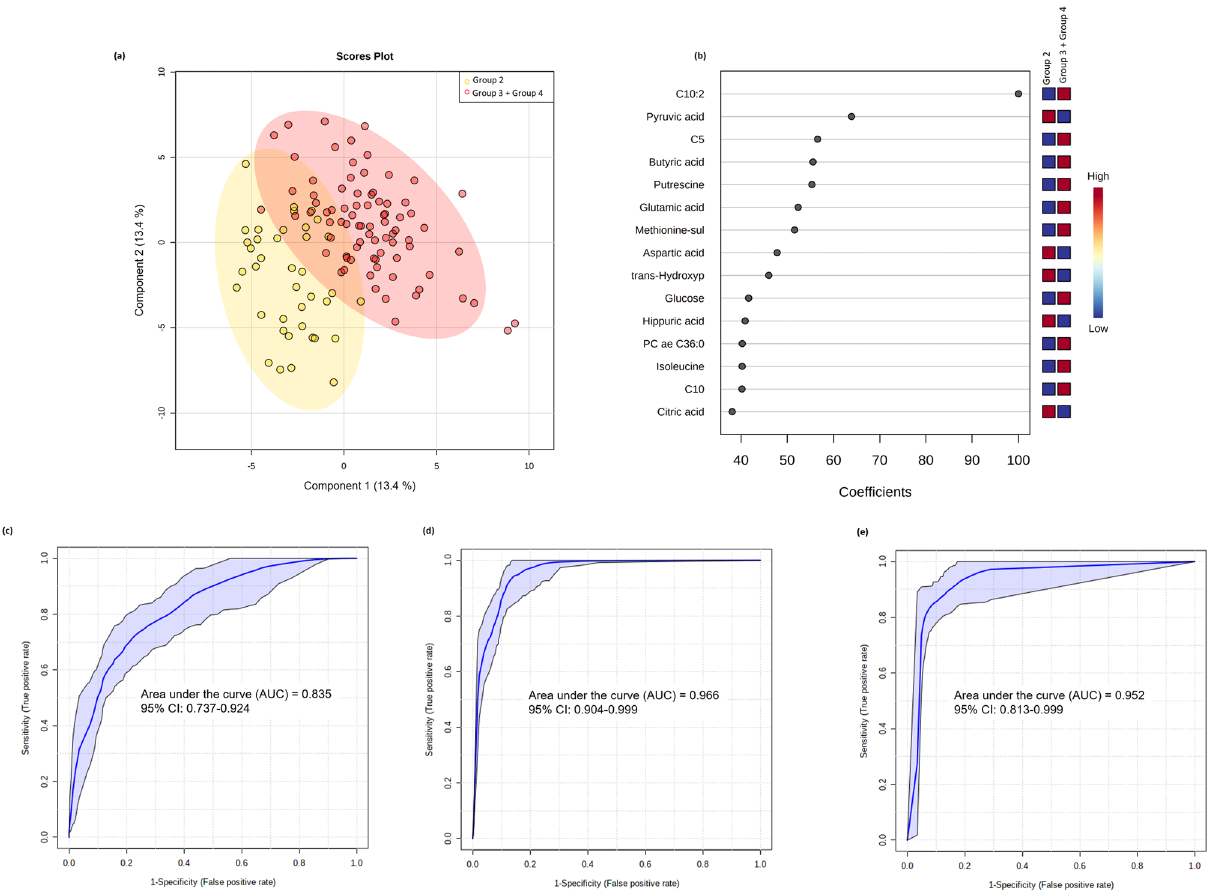
Figure 2. Multivariate analysis from plasma metabolome profile of G2 versus G3 and G4 patients. ( a ) Score scatter plot based on the PLS-DA models to explain the diagnosis (yellow for G2 and red for G3 + G4; ( b ) rank of the different metabolites (the top 15) identified by the PLS-DA according to the VIP coefficient on the x-axis. The most discriminating metabolites are shown in descending order of their coefficient scores. The color boxes indicate whether metabolite concentration is increased (red) or decreased (blue) in G2 vs G3 + G4; ( c ) ROC curve of the demographic/clinical data model; ( d ) ROC curve of the metabolite-only model; ( e ) ROC curve of the metabolite + demographic/clinical data model. The figures were drawn via MetaboAnalyst software v 4.0 (https:// www. metab oanal yst.